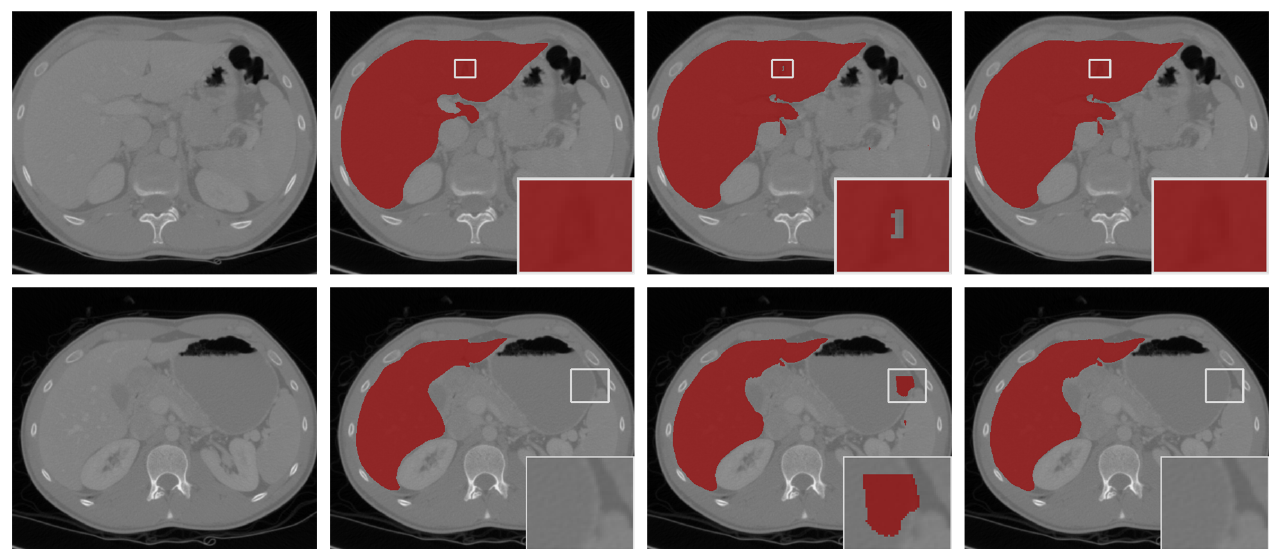
Figure 6. The segmentation results with post-processing. From left to right: the selected scans of the validation set ( first column ), ground-truths ( second column ), segmentation results of 3D FAS-UNet without post-processing ( third column ), and results with post-processing ( fourth column